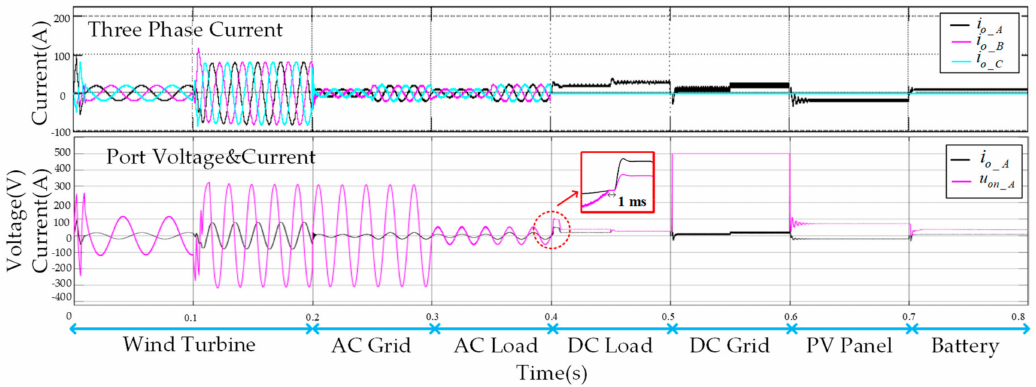
Figure 13. Simulation Results of Port Current and Voltage under Di ff erent Working